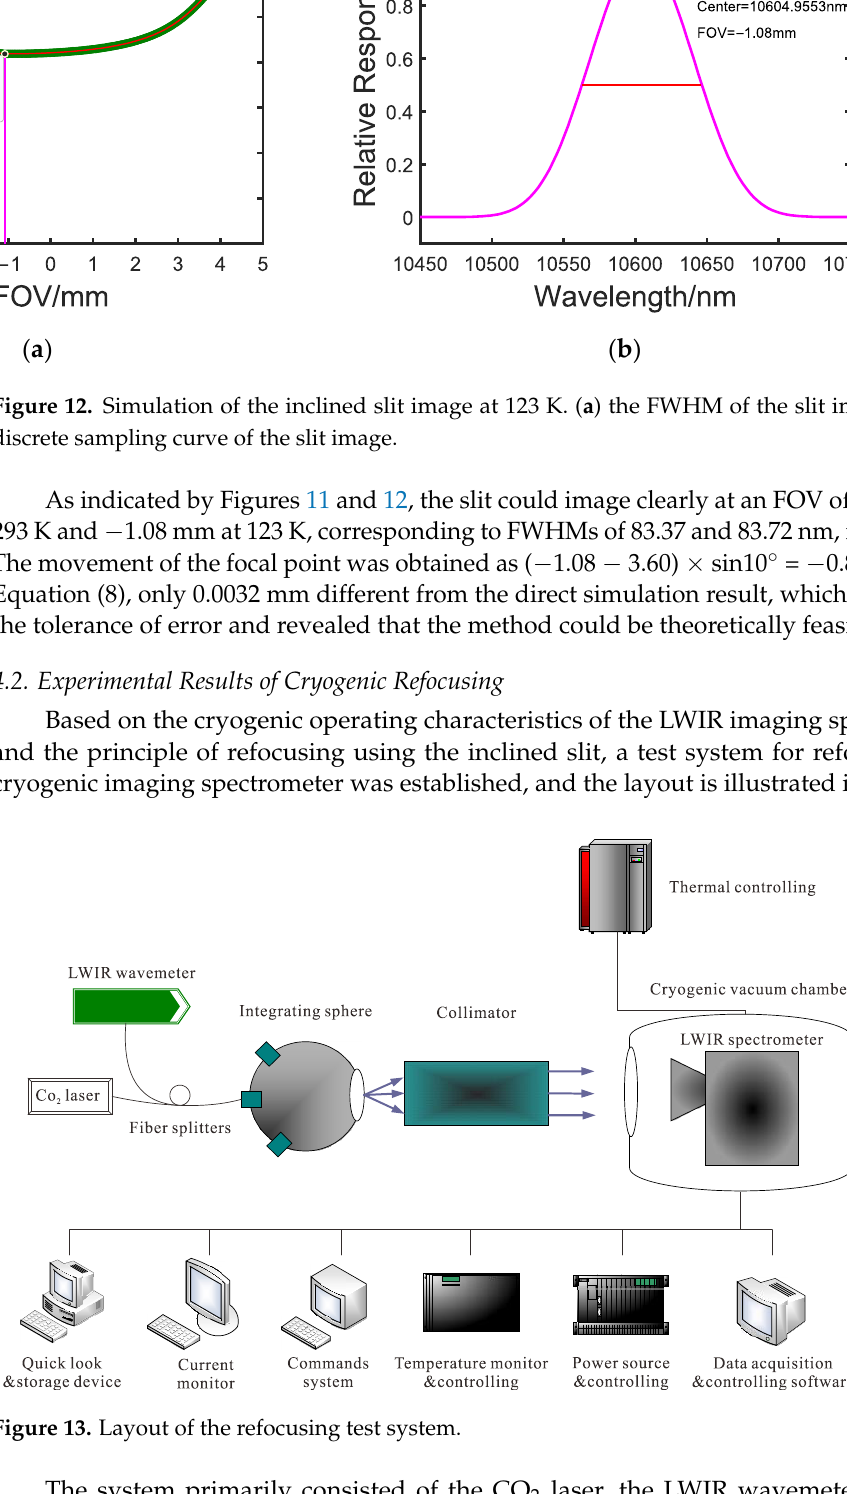
Figure 11. Simulation of the inclined slit image at 293 K. ( a ) the FWHM of the slit image; ( b ) the discrete sampling curve of the slit image.